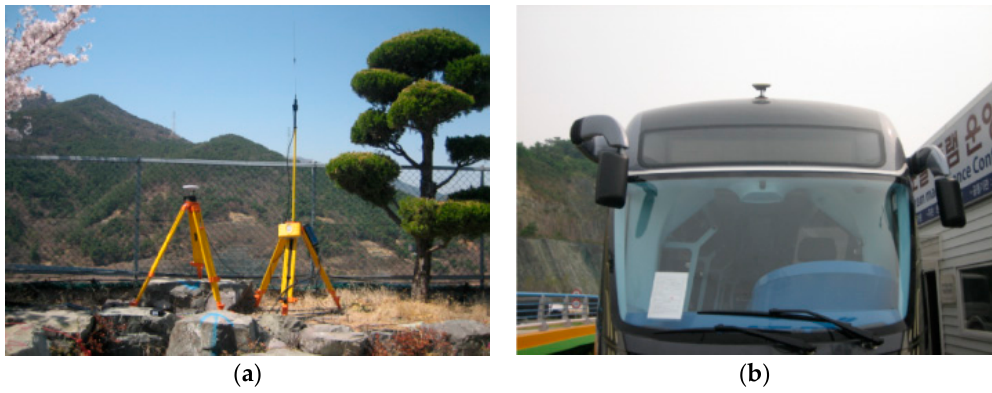
Figure 10. GPS measurement. ( a ) GPS base station; ( b ) Rover GPS on the vehicle.